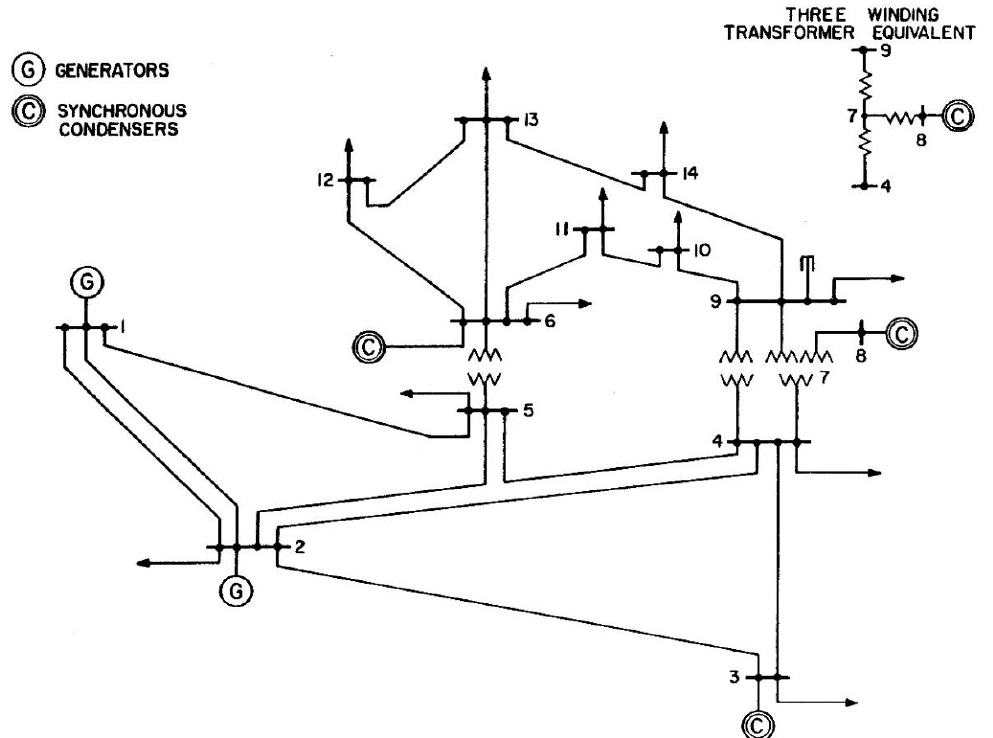
Figure 2. IEEE 14-node test system.